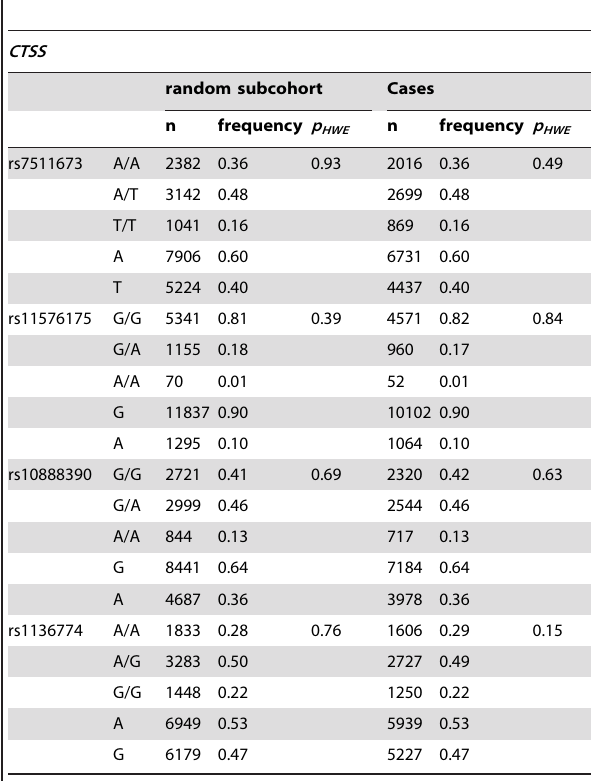
Table 2. Description of CTSS variability in subcohort and cases.